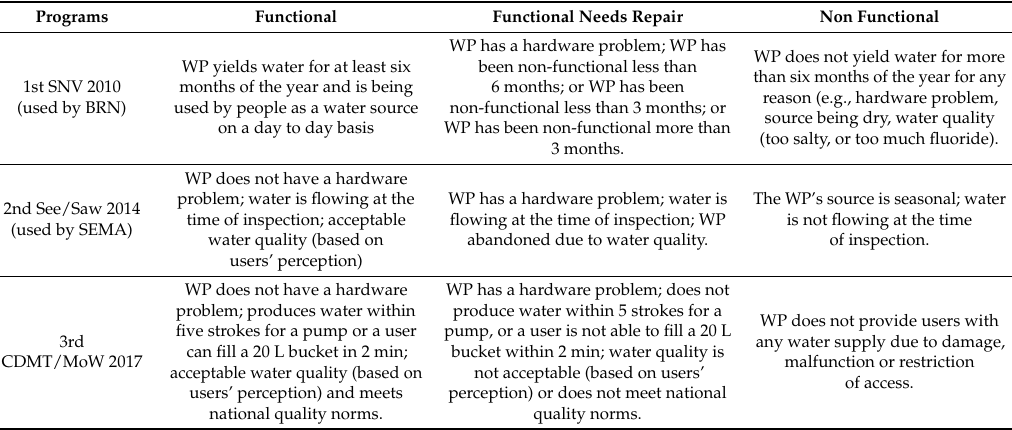
Table 3. Conditional formal programs for reporting the functionality status of a water